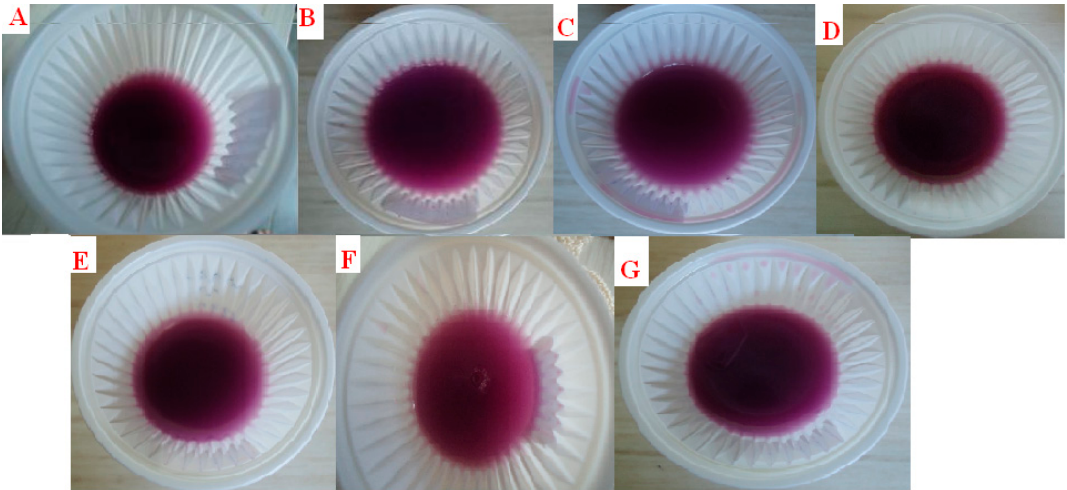
Figure 1. Photographs of the different formulations of gelatin samples produced from chicken feet. ( A – G ) gelatin-base gels obtained of according to formulation from experimental design. Table 2. Composition analysis of powdered gelatin from chicken